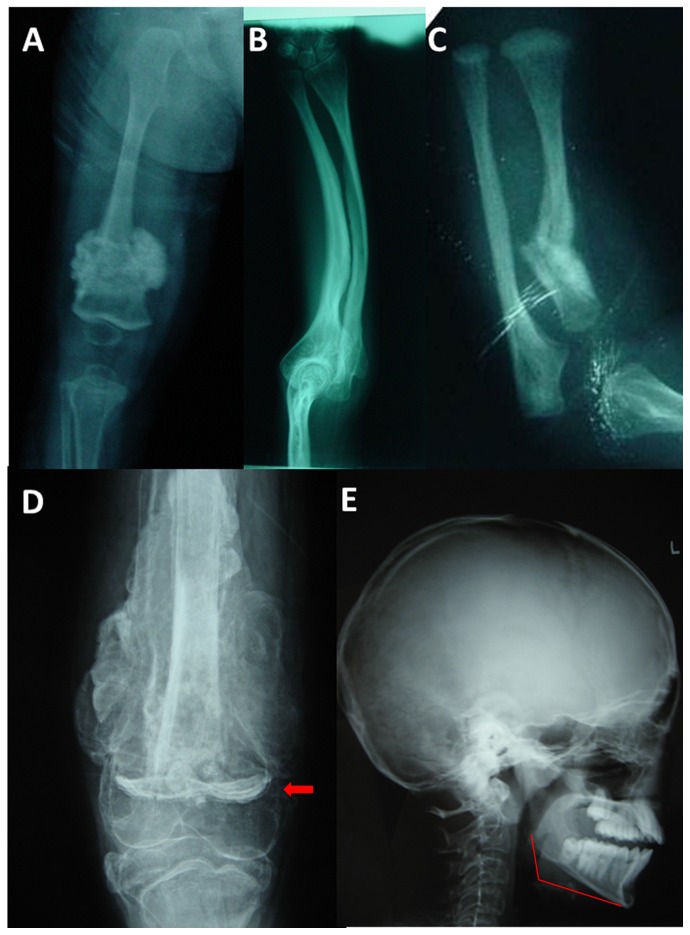
Typical radiographic manifestations.(A) Radiography of the proband of family 1 revealed an irregular radiodense mass arising from the right femur and widened metaphyses with metaphyseal dense bands. (B) Radiography of the affect mother of family 1 revealed calcification of the forearm interosseous membrane and radial-head dislocation. (C) Radiography of the proband of family 3 revealed metaphyseal dense bands of distal radial but no calcification of the forearm interosseous membrane or radial-head dislocation. (D) Radiography of the proband of family 4 revealed an irregular radiodense mass arising from the left femur and “zebra” lines (arrow) induced by intravenous ibandronate. (E) Skull radiography of the proband of family 4 revealed Wormian bones and mandibular hypoplasia (the drawn line represents the normal contour).